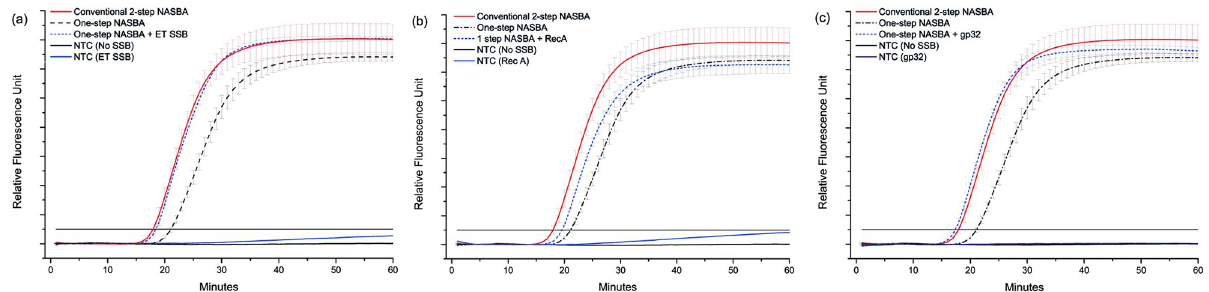
Fig 2. The effect of SSBs on NASBA of the synthetic HIV-1 RNA gene using (a) 80 μ g ET SSB, (b) 2 μ g RecA and (c) 1 μ g gp32 of a sample containing 2 x 10 5 copies of synthetic HIV-1 RNA (~C t 23) using the HIV-1 NASBA primer-probe set (S1 File). All graphs show conventional 2-step NASBA (red), 1-step NASBA (black dash/dot), 1-step NASBA with SSB (blue dashed), and NTC in absence (solid black) and presence (solid blue) of SSB (n = 3).